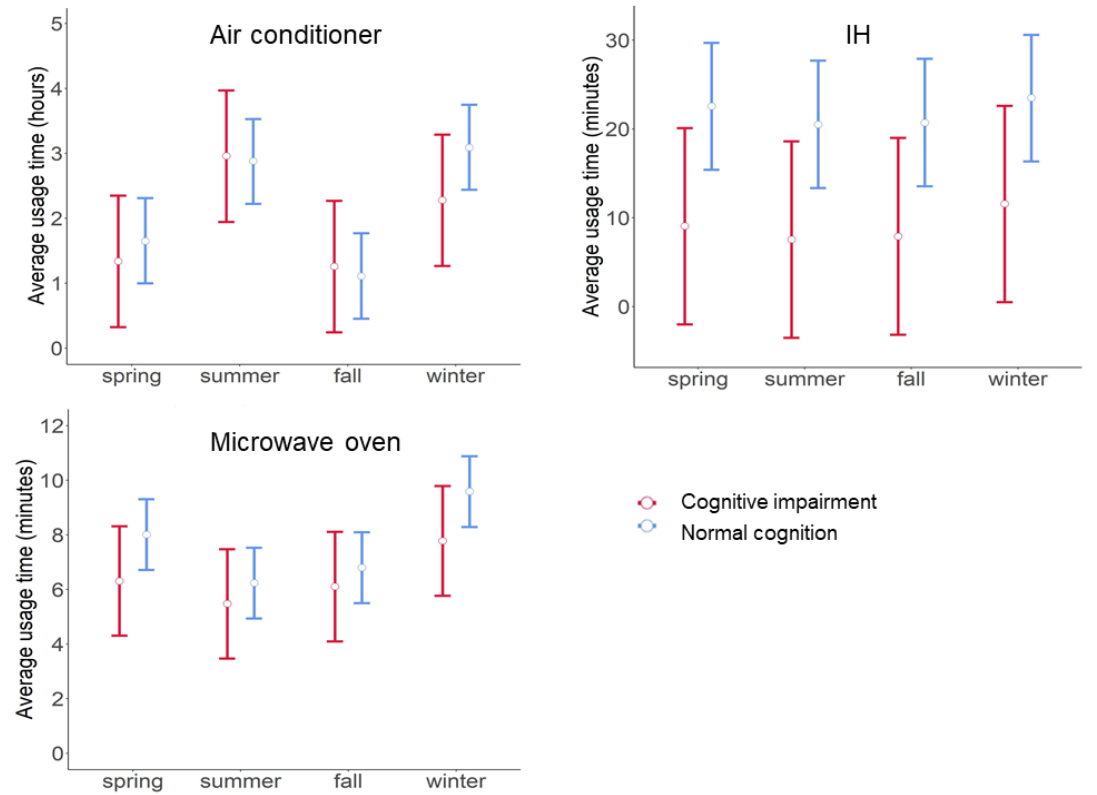
Figure 3. Estimated marginal means (EMMs) of average usage time per day of three in-home appliances in each season by cognitive status. EMMs ± 95% confidence intervals of average usage time per day in each season are plotted for the two groups (i.e., participants with cognitive impairment and those with normal cognition) based on the results of generalized linear mixed models.